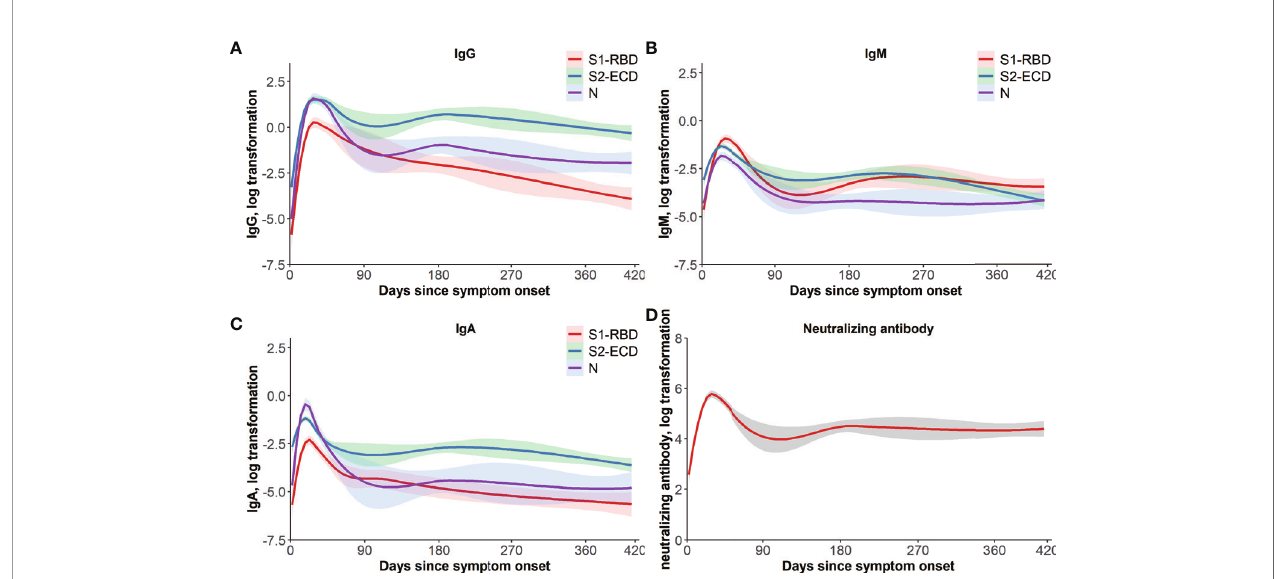
FIGURE 1 | One-year dynamic changes of immunoglobulins and Nab titers. LOWESS fi tting curves of S1-RBD, S2-ECD, and N-speci fi c IgG (A) , IgM (B) , and IgA (C) . Days since symptom onset form the x-axis and log transformation of antibodies T/C value tested by a QD-labeled LFIA form the y-axis, and the differences of temporal change of antibodies could be examined by the 95% con fi dence intervals belt. Red, green, and purple curves represent S1-RBD, S2-ECD, and N, respectively. (D) LOWESS fi tting curves of Nab titers over time. Days since symptom onset form the x-axis and log transformation of Nab titers form the y-axis. The dashed belt indicates 95% con fi dence intervals. ECD, extracellular domain; Ig, immunoglobulin; LFIA, lateral fl ow immunochromatographic assay; LOWESS, locally weighted scatterplot smoothing; N, nucleocapsid protein; Nab, neutralizing antibodies; QD, quantum dot; RBD, receptor-binding domain; S, spike; T/C,